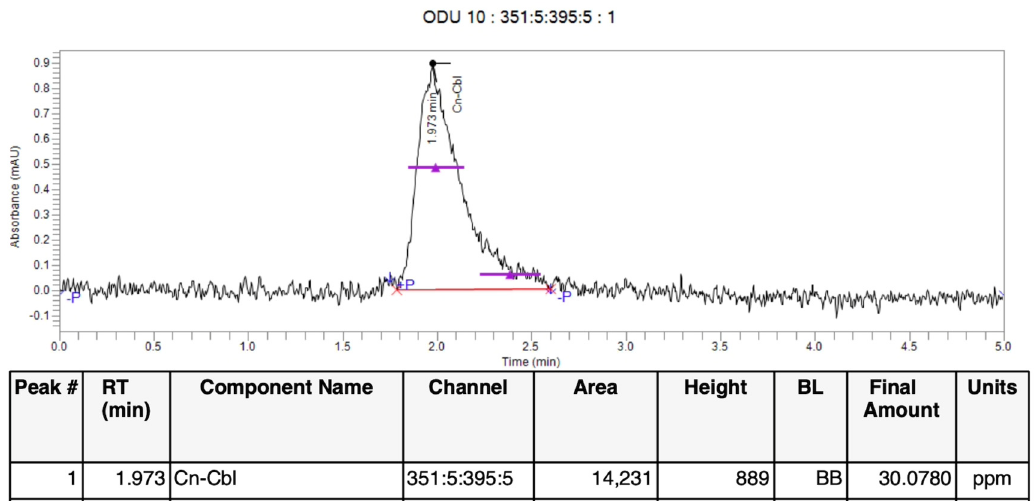
Figure 2. HPLC chromatogram of optimised purified vitamin B12 by CCD, oven dried U. lactuca extracted by UAE (ODU) run 10.